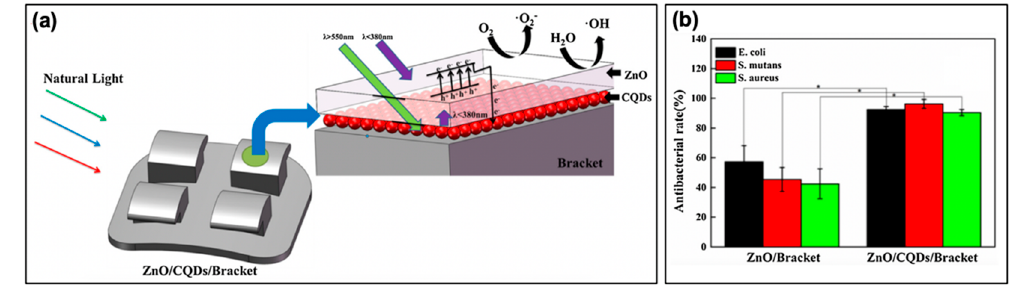
Figure 13. Carbon nanodots in materials applications. ( a ) Schematic for a zinc oxide (ZnO) and carbon nanodot (CQD) antimicrobial bracket coating for orthodontics materials. The schematic displays the reactive oxygen species (ROS, • O 2 − , • OH) generated by ultraviolet ( λ < 380 nm) activation of the ZnO coating, enhanced both by the up-conversion properties ( λ ex > 550 nm → λ em < 380 nm) and improved separation of electron / hole (e − / h + ) pairs resulting from carbon dot incorporation. ( b ) Antibacterial e ffi ciency of the bracket coatings under natural light irradiation for multiple bacterial strains; * p < 0.01. For additional details regarding the reported studies, the reader is referred to Table 2 of the main text.